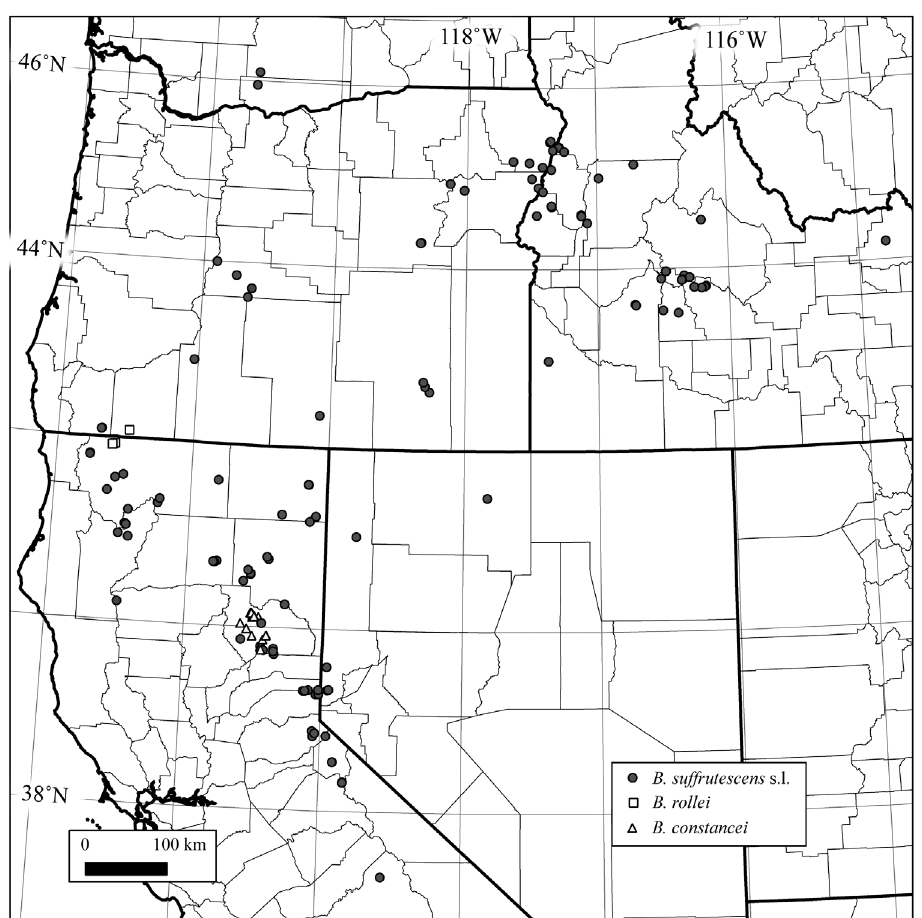
Figure 1. Geographic distribution of 498 initial individuals. Only 307 diploids were retained for diploid- level molecular analyses. All maps were created in QGIS (Quantum GIS 1137 Development Team